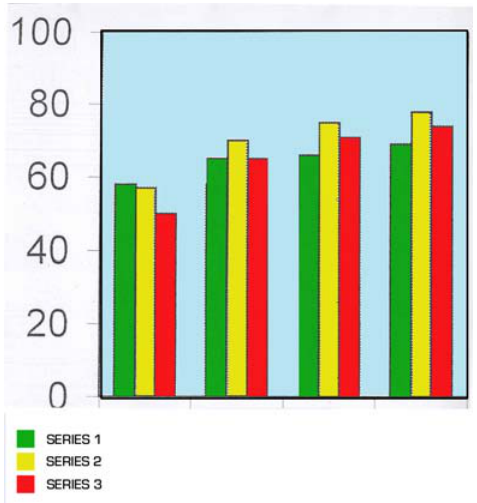
FIGURE 1. Immediate subjective well being (yellow), total QOL (green), and psychological health (red) before and 1 week, 1 month, and 3 months after the 5-day intervention as measured by the SEQOL questionnaire. It is interesting that the participants seem to continue to improve their QOL and health in the months after the intervention. We believe that this is because they are using the tools and concepts for personal development, which they are trained to use during the 5-day